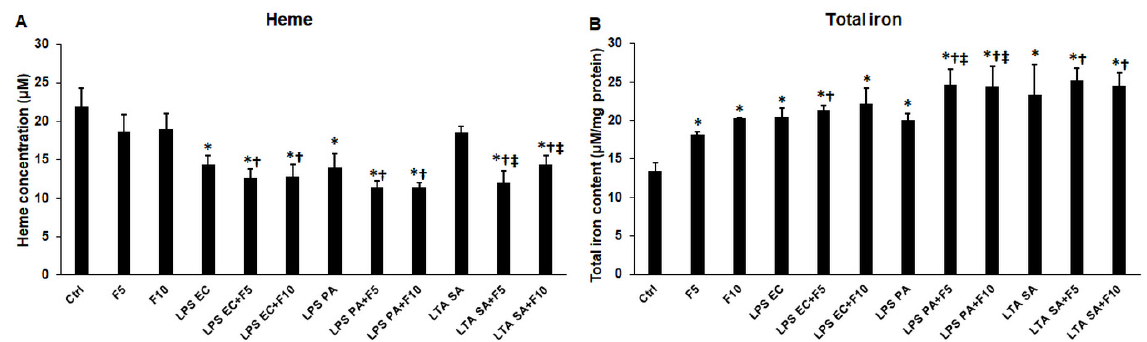
Figure 8. Determinations of heme concentration ( A ) and total iron content ( B ) of E. coli or P. aeruginosa LPS and S. aureus LTA and/or fractalkine-treated THP-1 cells. Heme concentration of the THP-1 cells was measured using a Heme Assay Kit. Iron content of the cells was determined using a colorimetric ferrozine-based assay and it was expressed as μ M iron/mg protein. The columns represent mean values and error bars indicate standard deviation (SD) of three independent experiments ( n = 3). The heme and total iron measurements were carried out in quadruplicate in each independent experiment. Statistical significance was determined by two-way ANOVA (considering the number of the categorical variables) followed by Scheffe’s post hoc test. Asterisk marks p < 0.05 compared to the control. Cross shows p < 0.05 compared to the fractalkine treatment. Double cross indicates p < 0.05 compared to the LPS or LTA treatments, respectively. Abbreviations: F5—fractalkine 5 ng/mL;